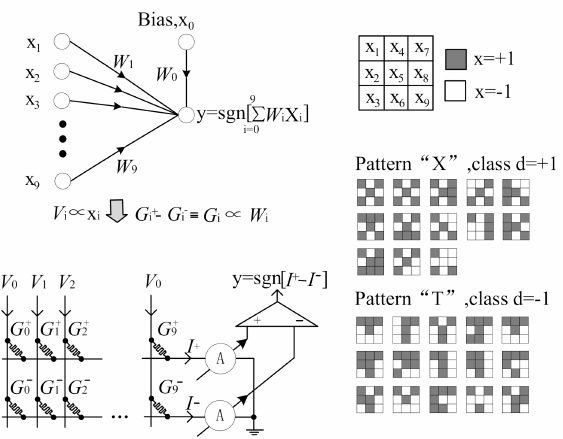
Figure 14. Single-layer perceptron network memristor circuit.